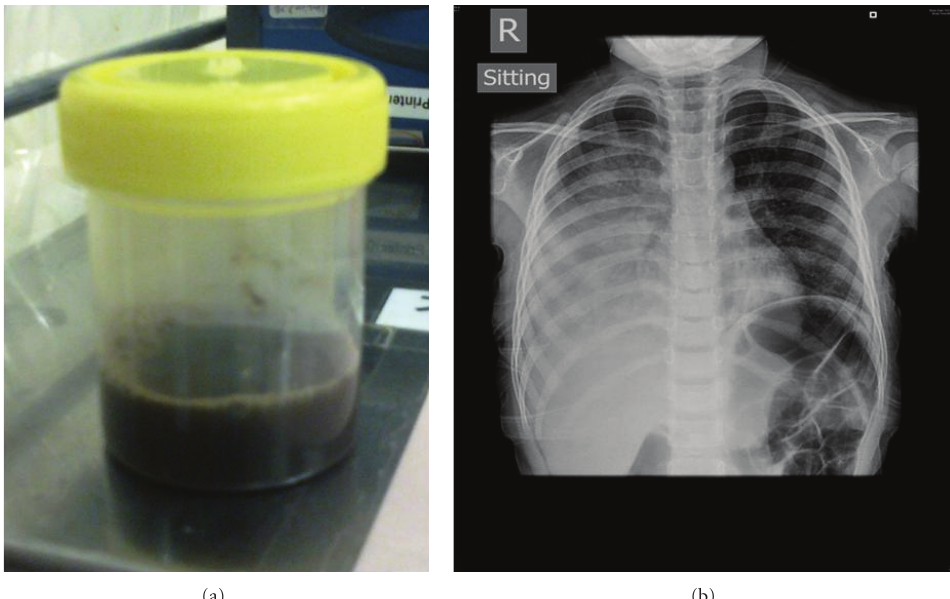
Figure 1: Right pleural e ff usion associated with pneumococcal pneumonia. Mycoplasma and Metapneumovirus were also detected in the tracheal aspirates to suggest co-infection in this case. The drained pleural fluid was dark and turbid and yielded Streptococcus pneumoniae (serotype